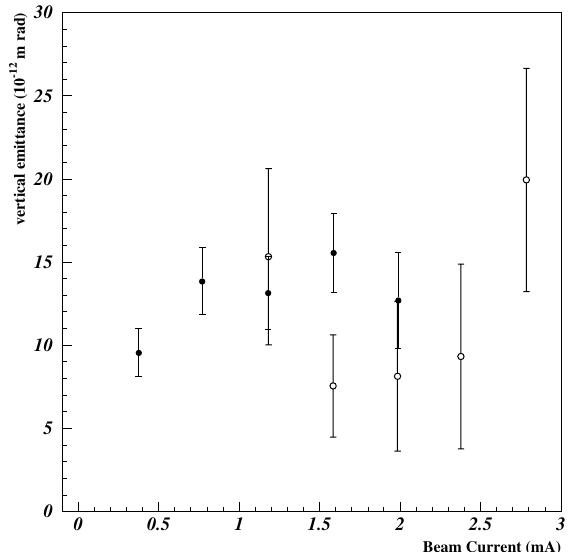
FIG. 10. Superposition of the two measurements. Solid and open circles represent, respectively, the results of ( 2000 = 12 = 05 ) and ( 2000 = 12 = 14 ).